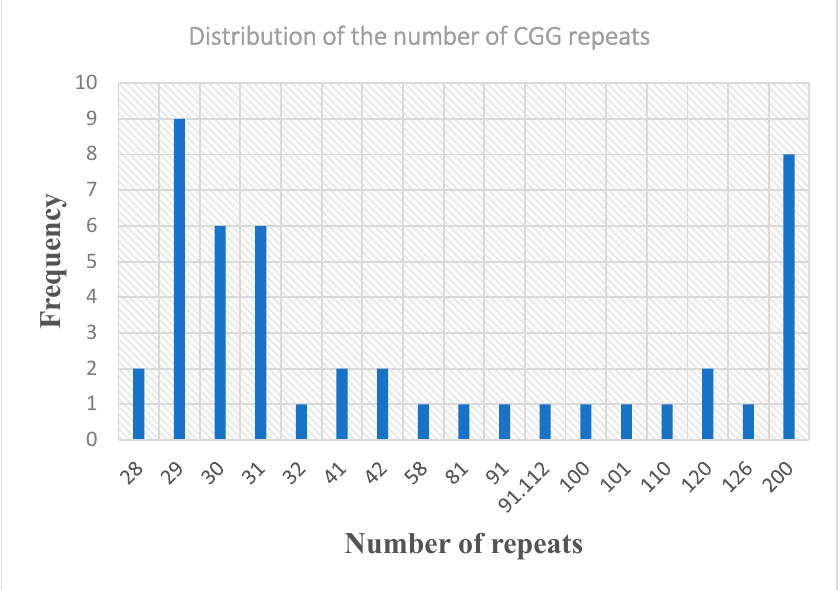
Figure 3. Distribution of Cytocine-Guanine-Guanine (CGG) repeat in the extended family. Table 2. Consequences of transmitting a maternal PM allele.